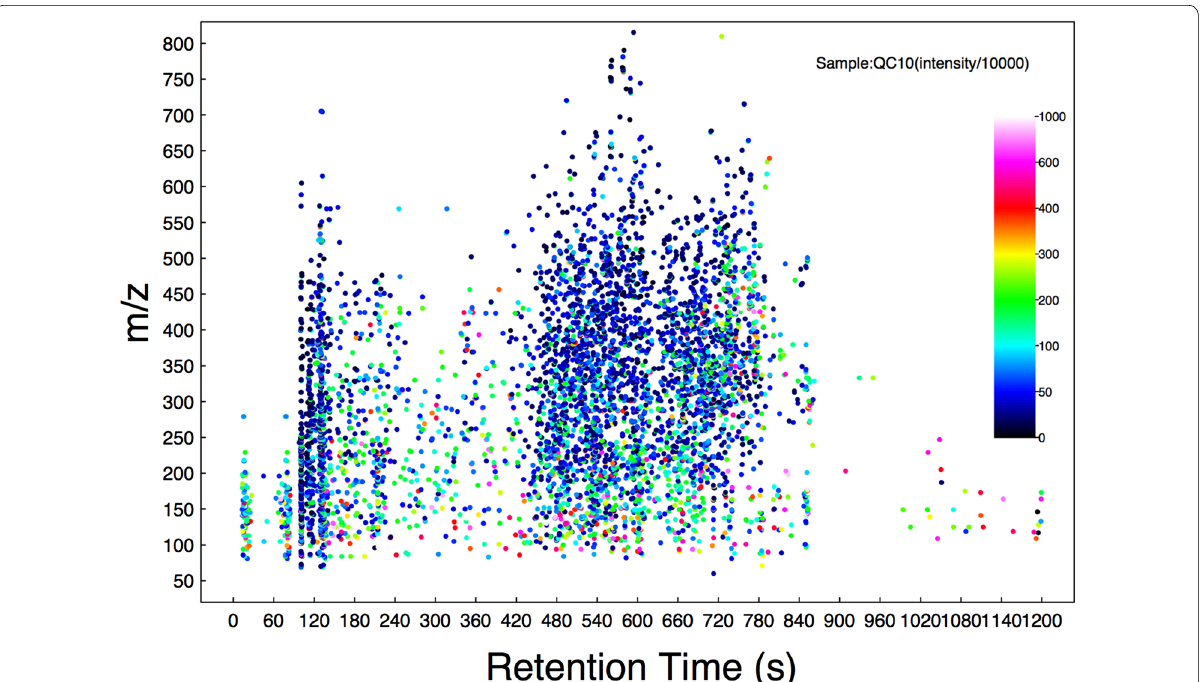
Fig. 1 A chromatogram of total